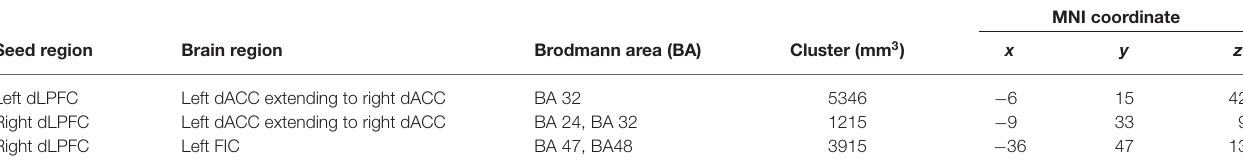
TABLE 1 | Regions with significant correlations between WM accuracy and rsFC